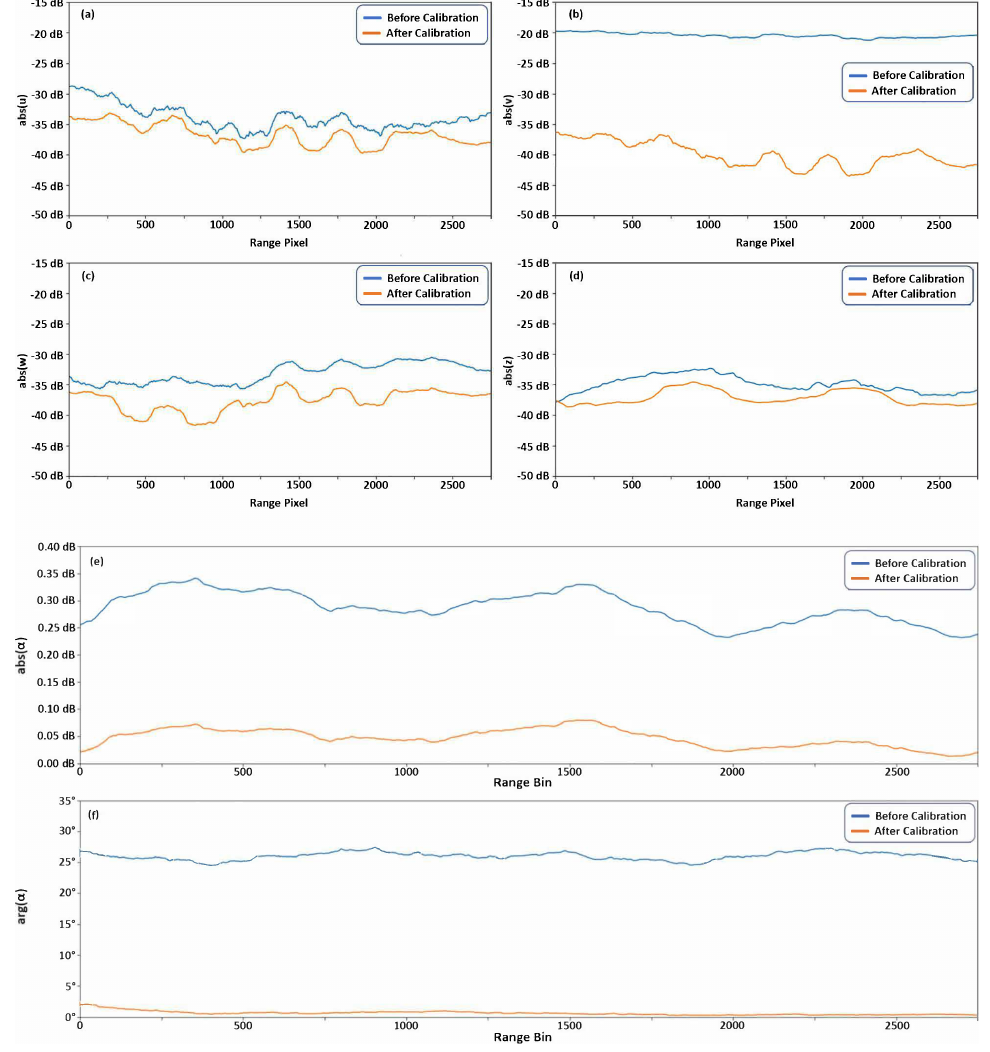
Figure 6. Variation of crosstalk and channel imbalance parameters estimated using Quegan’s algorithm. The subfigures shows the variation of the parameters as follows: (a) abs( u ) , (b) abs( v ) , (c) abs( w ) , (d) abs( z ) , (e) abs( α ) , (f) arg( α ) All the crosstalk parameters and the channel imbalance parameter have reduced after performing